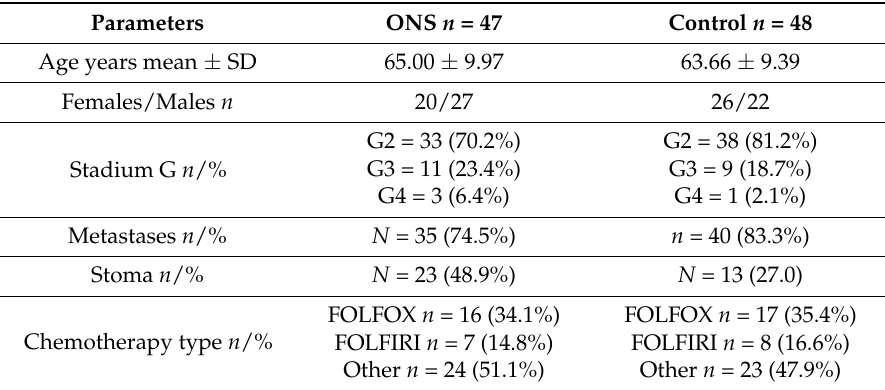
Table 1. The characteristics of the study